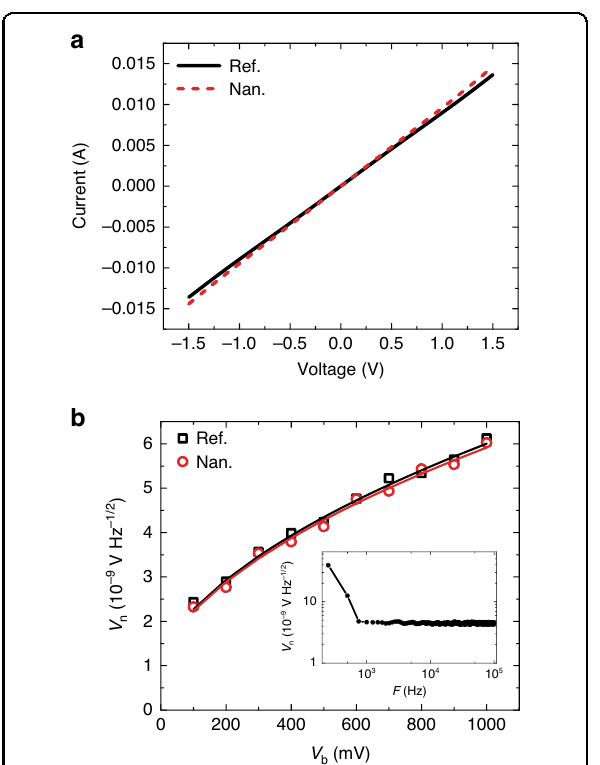
Fig. 2 Dark current and noise characterization. a Current – voltage characteristic curves of reference and nanogroove devices. b Typical calculated (lines) and measured (squares and circles) noise level of the nanogroove and reference devices. The inset is a typical measured noise spectrum.